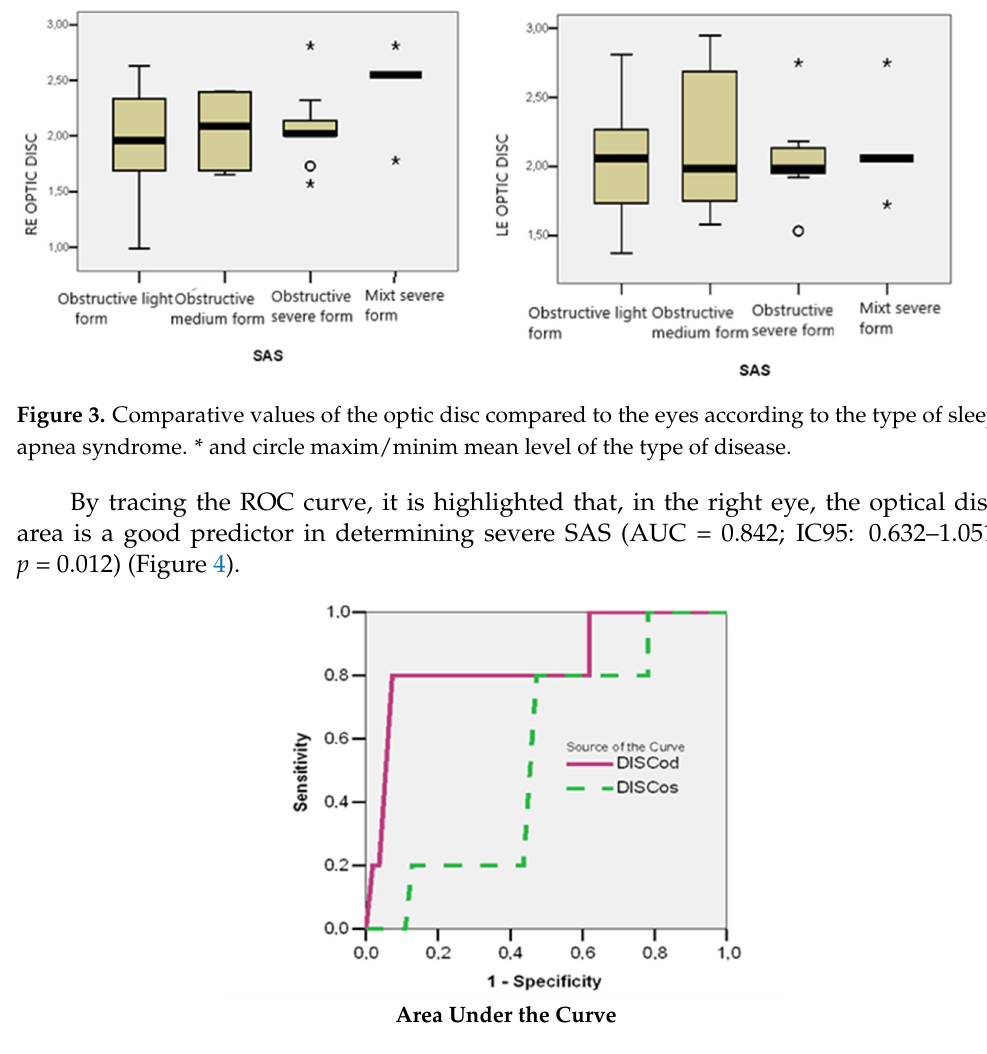
Figure 2. Percentage of conditions associated with sleep apnea syndrome.